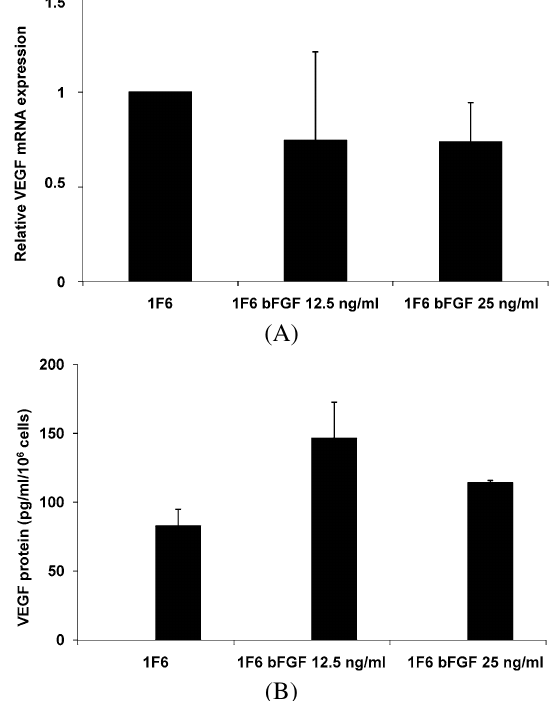
Fig. 4. VEGF mRNA expression and VEGF protein production by 1F6 cells treated with exogenous rhbFGF 12.5 or 25 ng/ml for 72 h. (A) Total RNA was isolated and VEGF mRNA levels were deter- mined by light-cycler RT-PCR. Relative expression in 1F6 was set at 1. (B) Conditioned media was 8 times concentrated and VEGF secretion was measured by ELISA. After exposure to rhbFGF, cells were counted. Results were expressed in pg/ml/10 6 cells. Bars rep- resent mean values ± range of duplicate